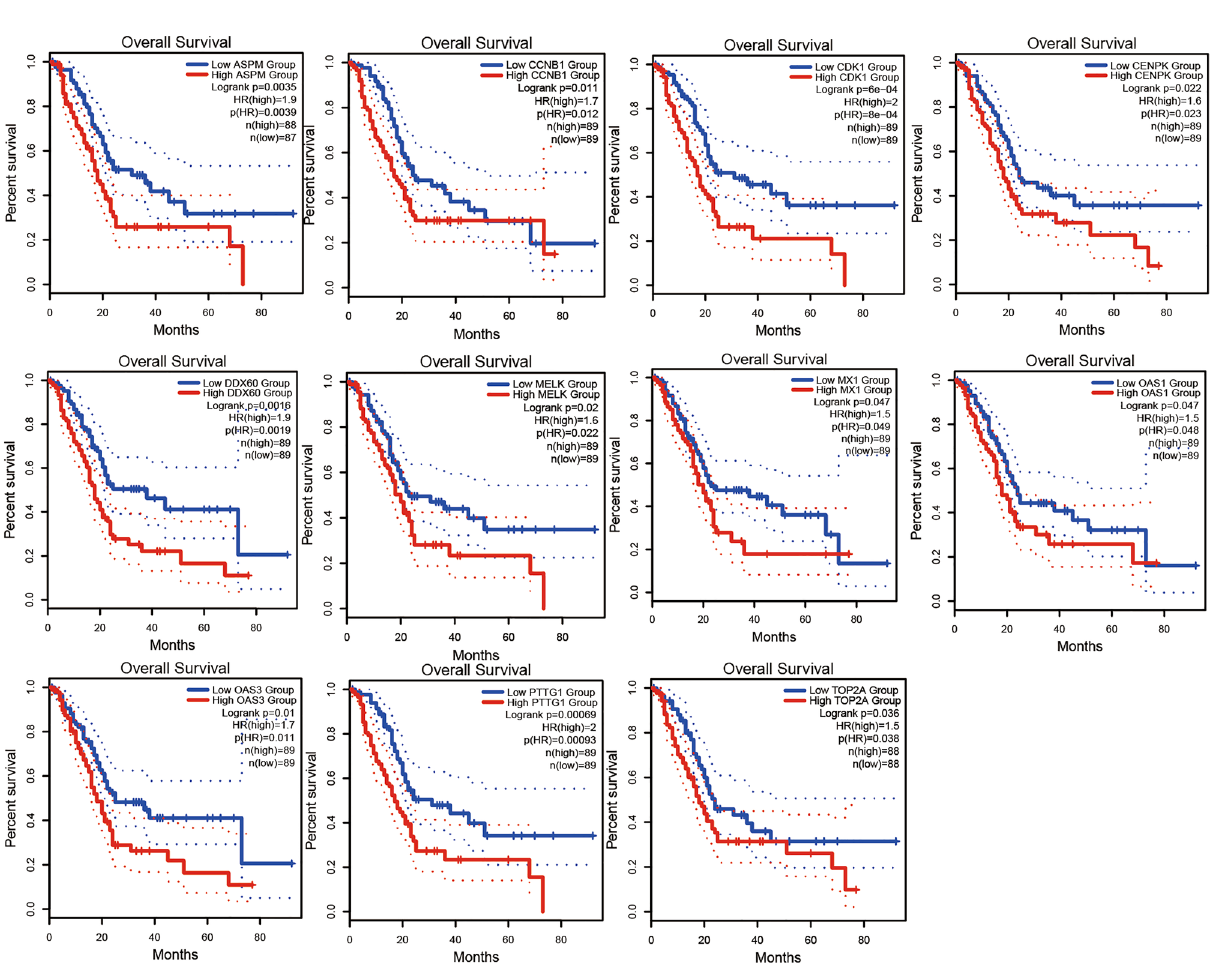
Figure 4. Analysis of correlation between the expression of central genes and the overall survival of PDAC patients via